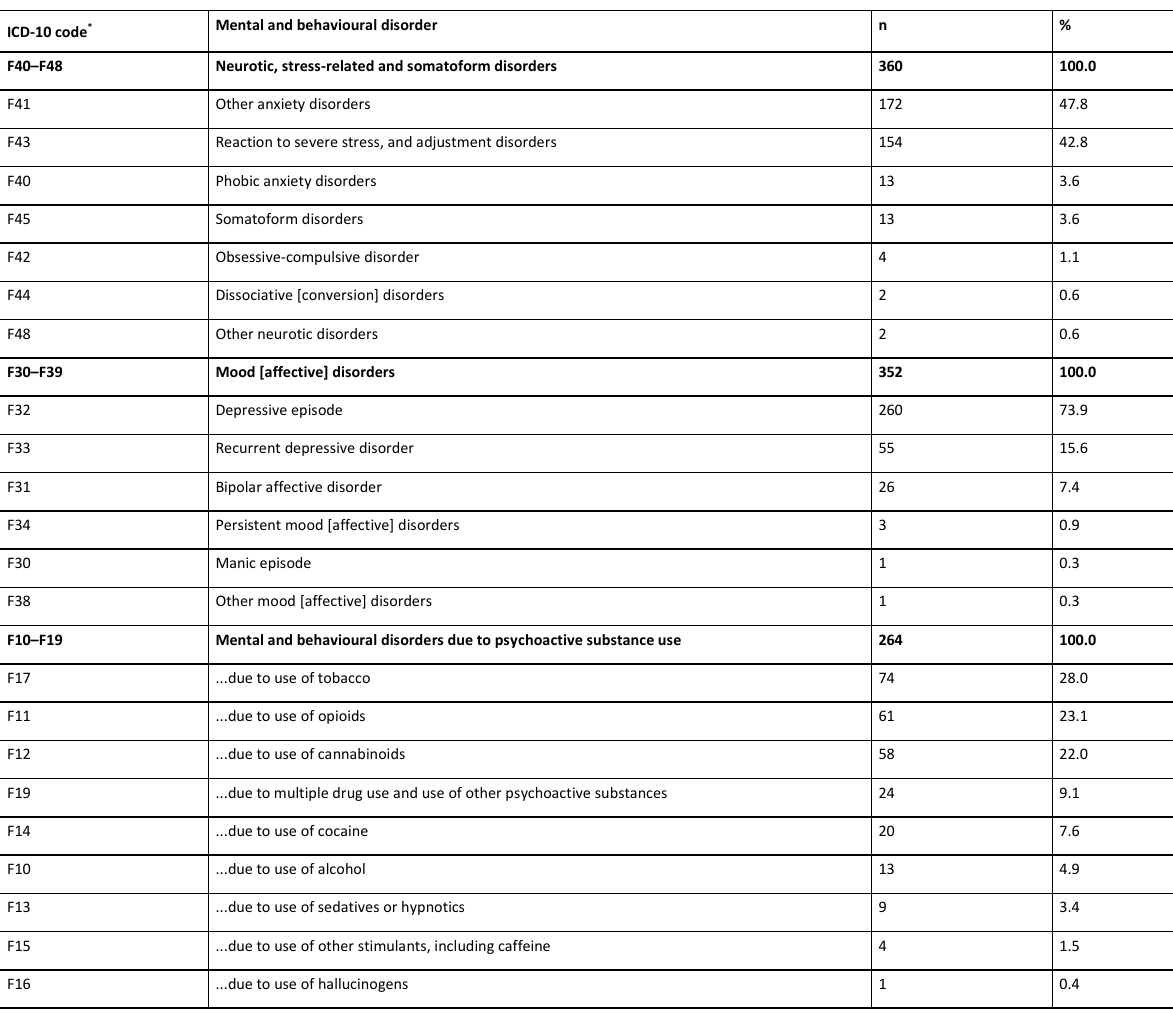
Table S1: Proportion of diagnostic groups of all perinatal mental disorders (% of all recorded F-diagnoses, n = 1174). ICD-10 code * Mental and behavioural disorder